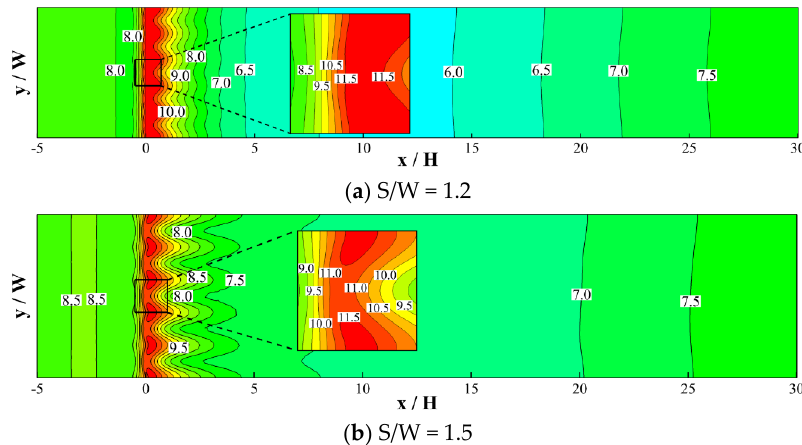
Figure 12. Pedestrian wind contours for different tree spaces (H = 12 m).